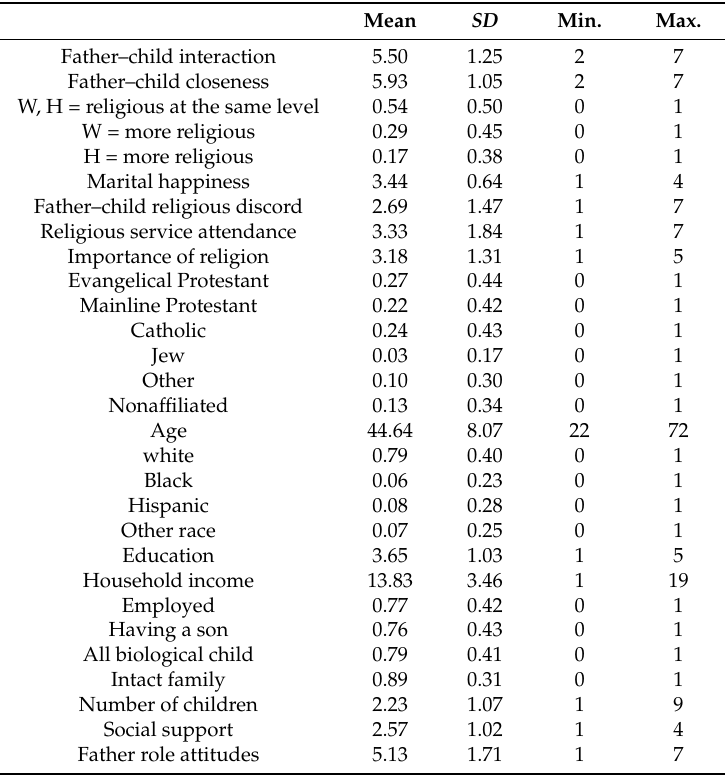
Table A1. Descriptive statistics ( n =